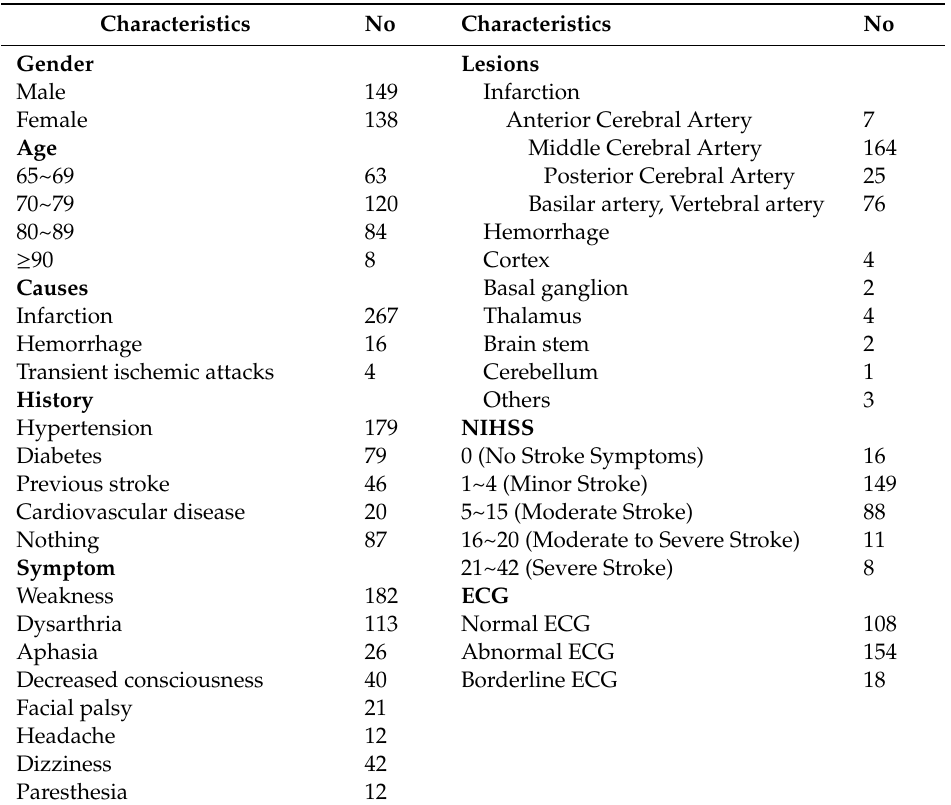
Table 2. Baseline characteristics for subjects ( N = 287).